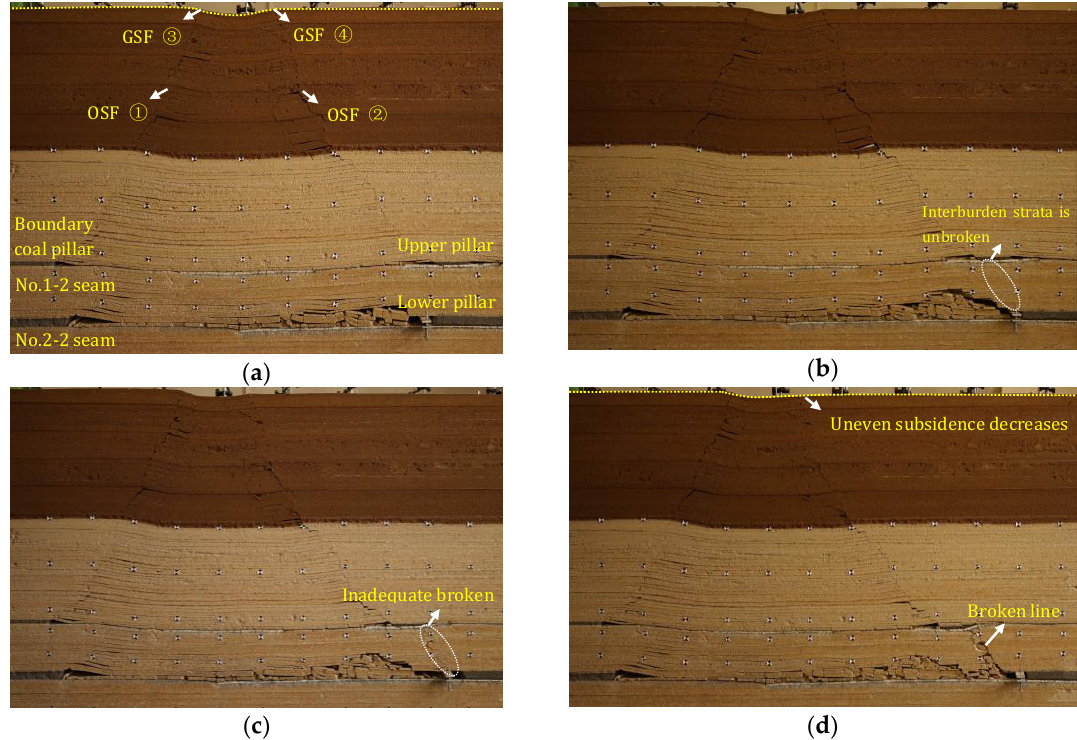
Figure 13. Physical simulation of different CPMD: ( a ) Aligned pillars; ( b ) CPMD of 10 m; ( c ) CPMD of 30 m, and ( d ) CPMD of 40